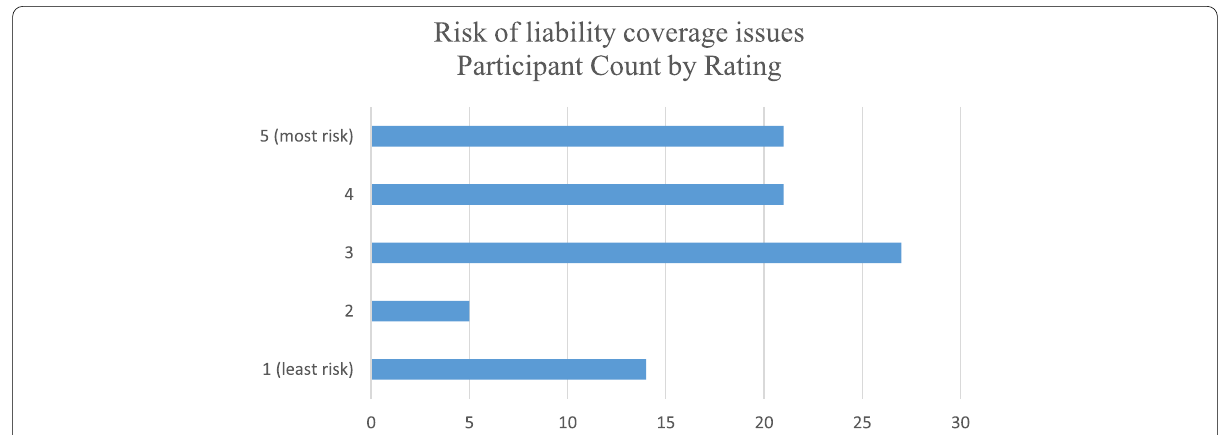
Fig. 5 Count of respondents’ ratings (one through five) for risk due to potential professional liability coverage issues